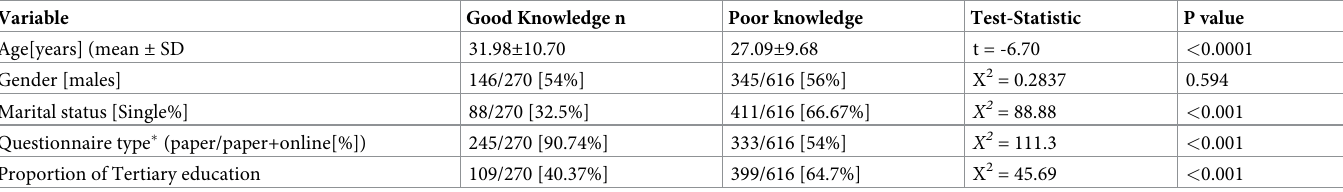
Table 2. Relationship of demographic characteristics to knowledge.